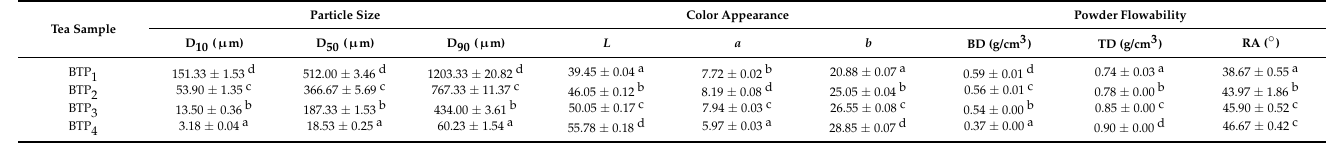
Figure 2. Particle-size distributions of BTPs at different pulverizing scales. Table 1. Particle size, color appearance and powder flowability of BTPs at different pulverizing scales.